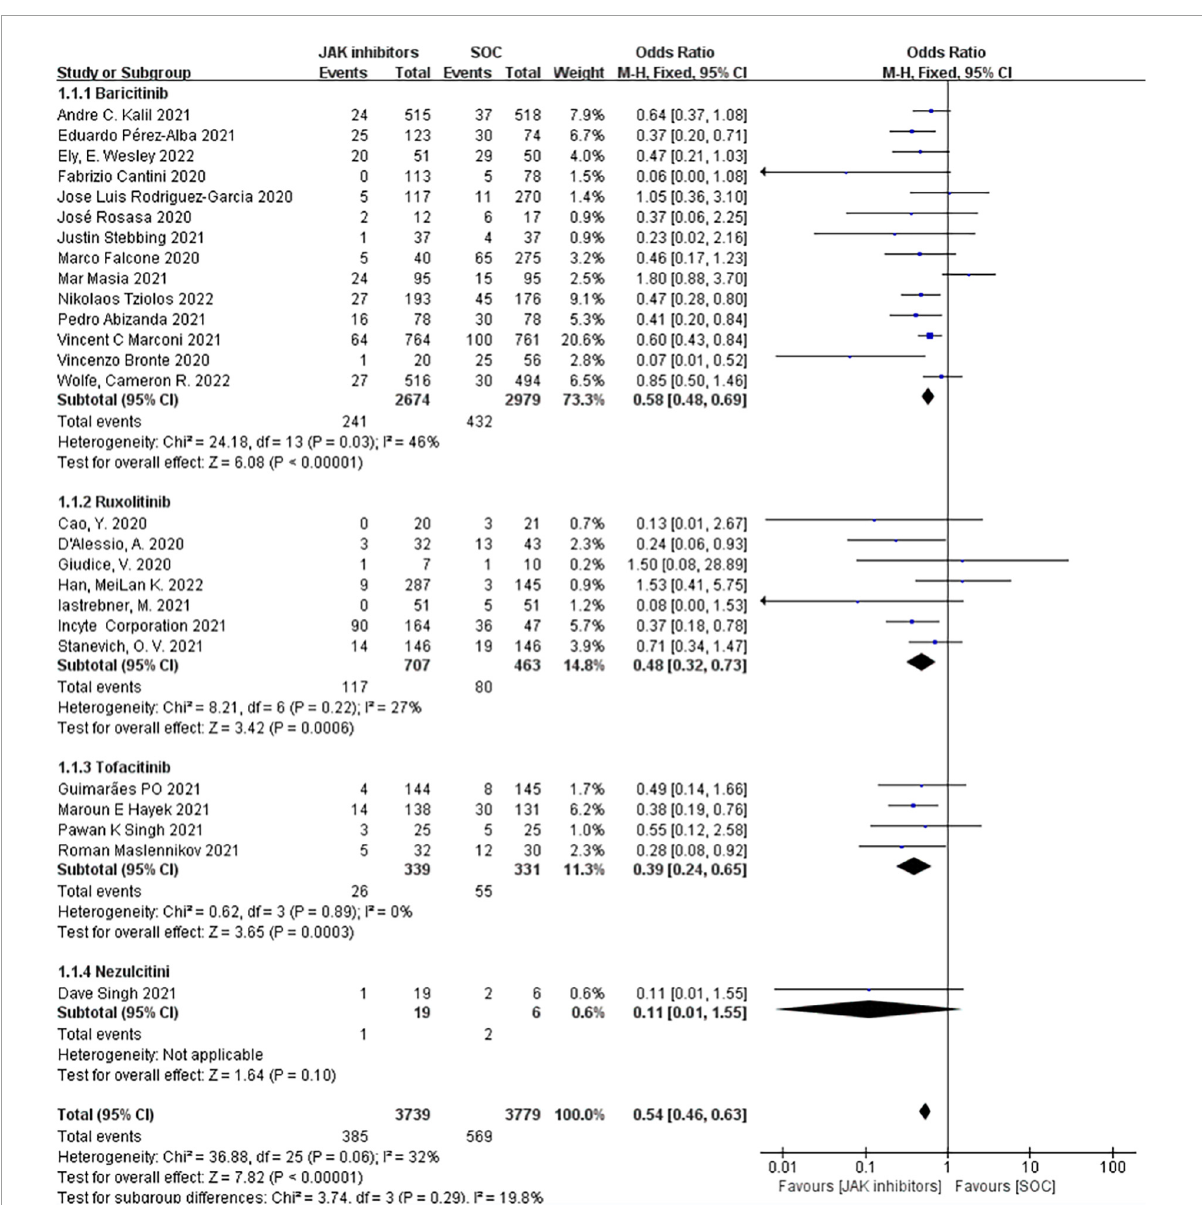
FIGURE3 Forest plots of effect of JAK inhibitors compared to SOC on mortality. The study was divided into four subgroups by different drugs. SOC, standard of